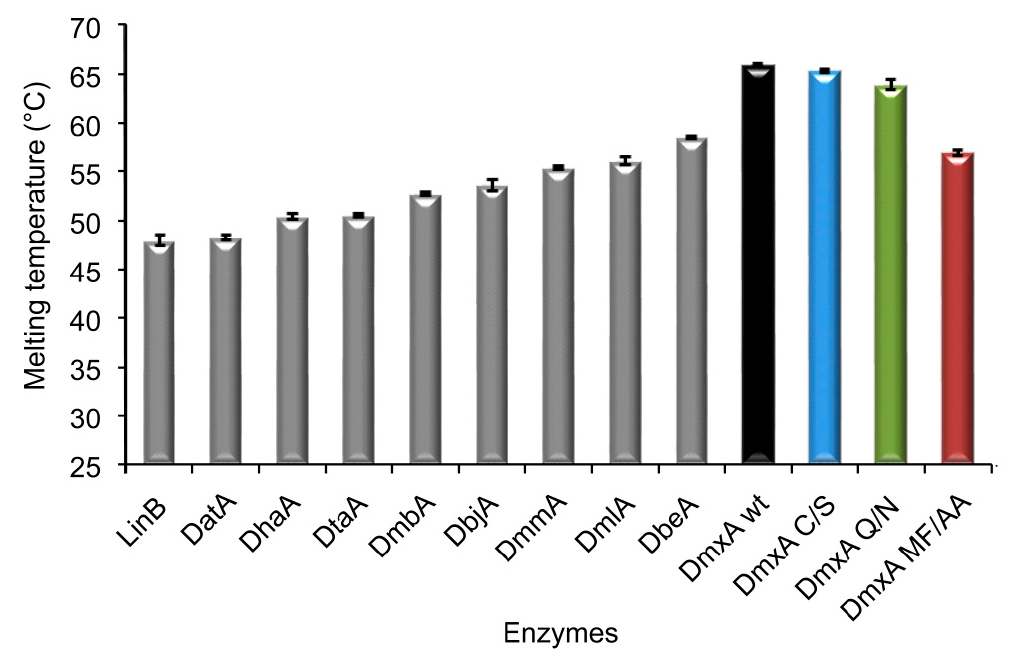
Figure 1. Comparison of melting temperatures of selected biochemically characterized HLD-II members with haloalkane dehalogenase DmxA wt and its variants constructed in this study. Wild type DmxA exhibits the highest stability ( T m,app = 65.9 ± 0.1 °C) of so far characterized enzymes from HLD-II subfamily. Error bars represent standard deviations from at least three independent experiments.